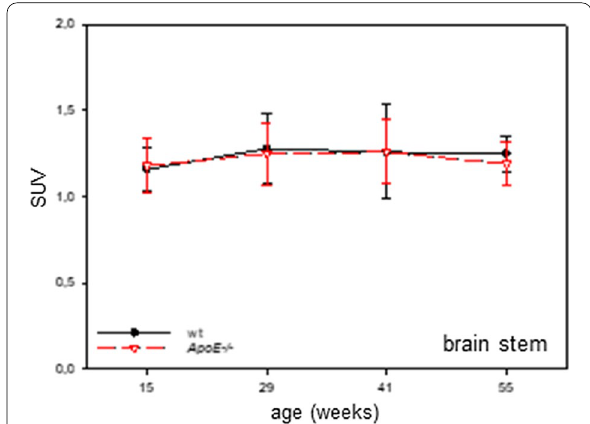
Fig. 3 Quantification of [ 18 F]FDG uptake in the brain stem given as absolute SUVs of wild type (wt; n 8) and Apolipoprotein E-deficient = ( ApoE / ; n 8) mice at the age of 15, 29, 41, and 55 weeks. Notably, − − = the brain stem showed neither age-dependent nor strain-dependent differences in [ 18 F]FDG uptake. Values are given as mean ±